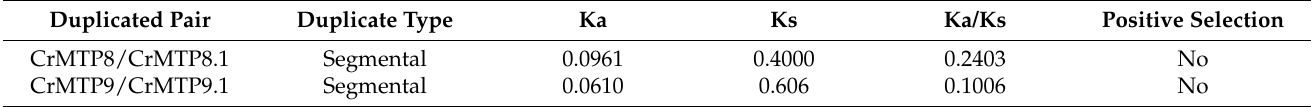
Table 2. Ka/Ks analysis and duplicated type calculation for CrMTP